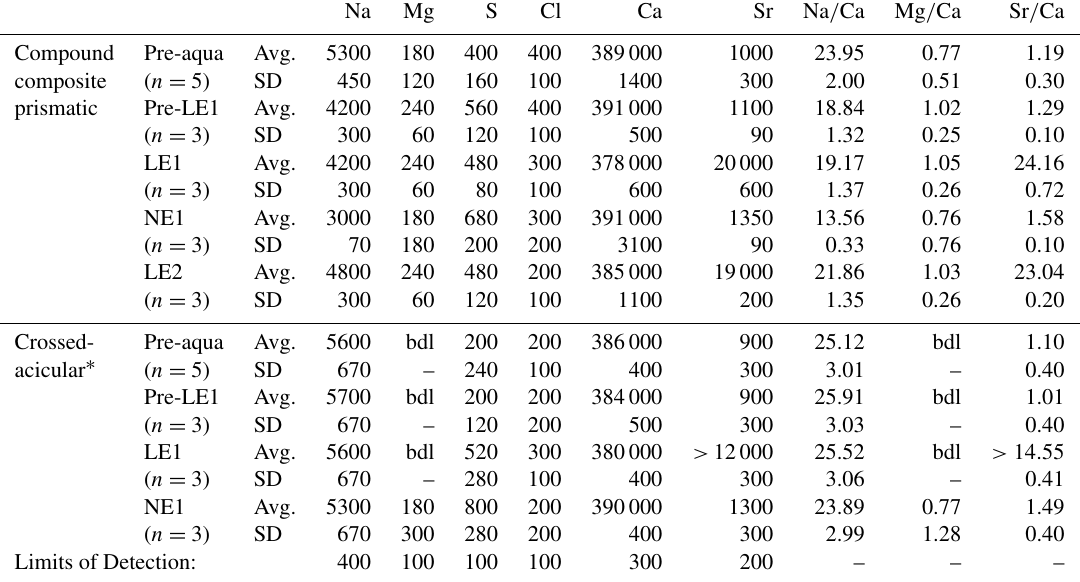
Table 1. Geochemical composition of K. rhytiphora obtained from wavelength-dispersive X-ray spectrometry (WDS) electron probe micro- ratios for shell compositions grown under different conditions in the wild (pre-aqua) in aquaculture during pulsed Sr-labelled (LE1 and LE2) and unlabelled (pre-NE1 and NE1)